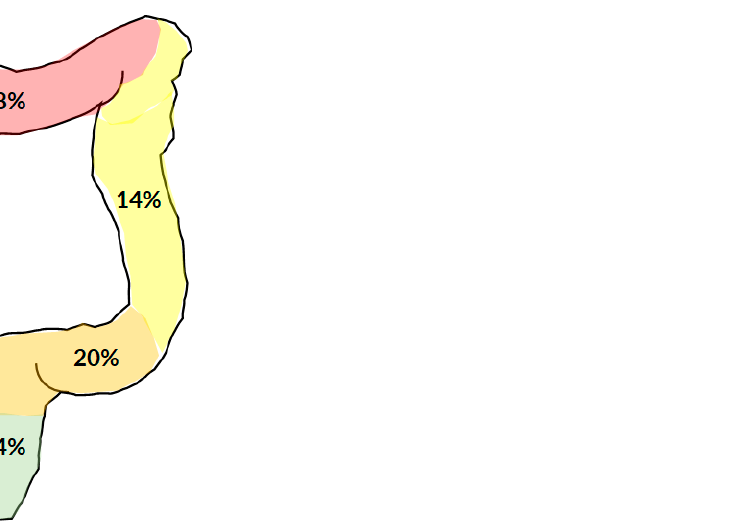
Figure 6. The most typical localization of colonic lipoma causing colocolic intussusception.